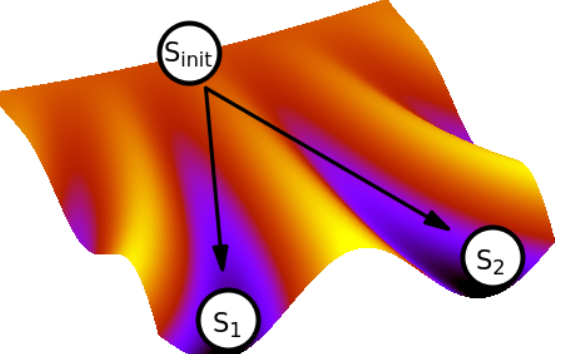
Figure 3. The epigenetic landscape. The cell state is represented by a ball rolling down from an undif- ferentiated initial state S init along one of the ‘canals’ until it reaches the respective differentiated state (here S 1 or S 2